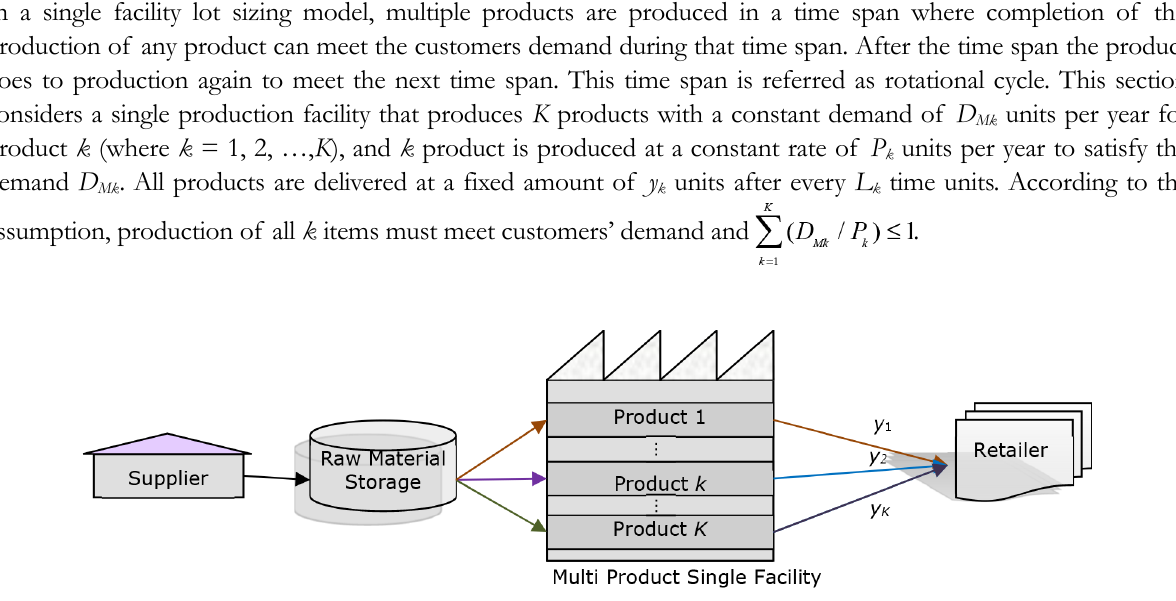
Figure 5. Single-supplier, multi-product and Single-buyer supply chain